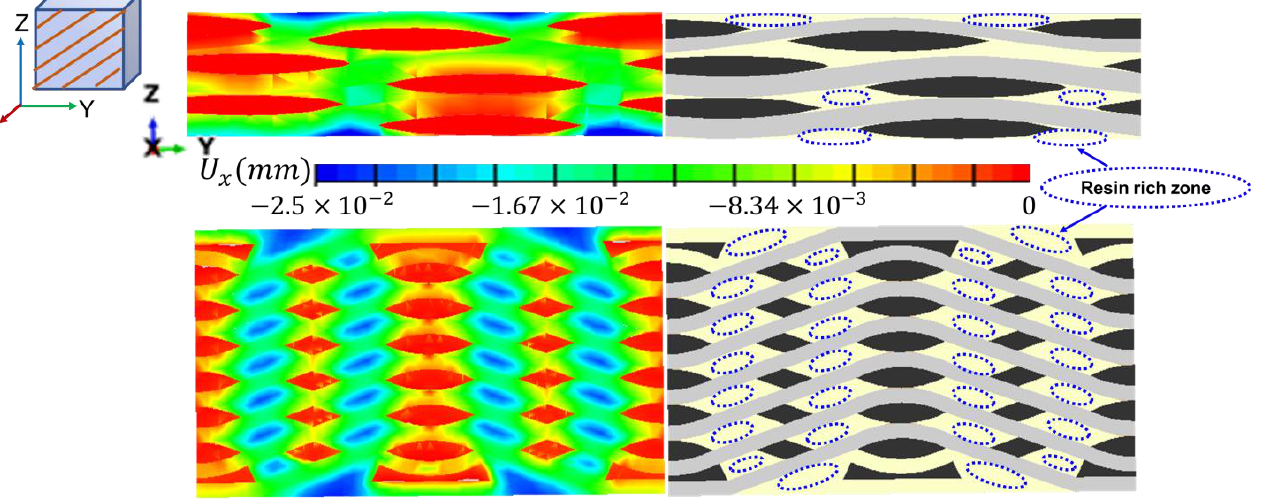
Figure 9. Local shrinkage displacement in PWC and AWC after thermal oxidative ageing for 16 days.